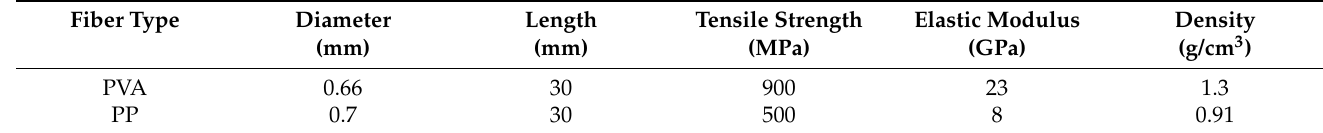
Table 2. Mechanical properties of PVA fiber and PP fiber [29,30].